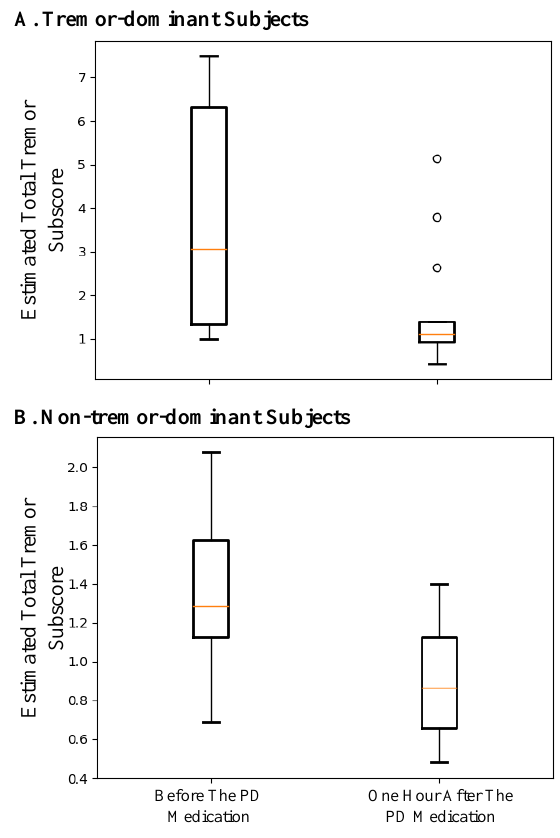
Figure 4. Total tremor subscore estimated using the gradient tree boosting method for ( A ) tremor- dominant and ( B ) non-tremor-dominant subjects before and about one hour after taking the first scheduled dose of PD